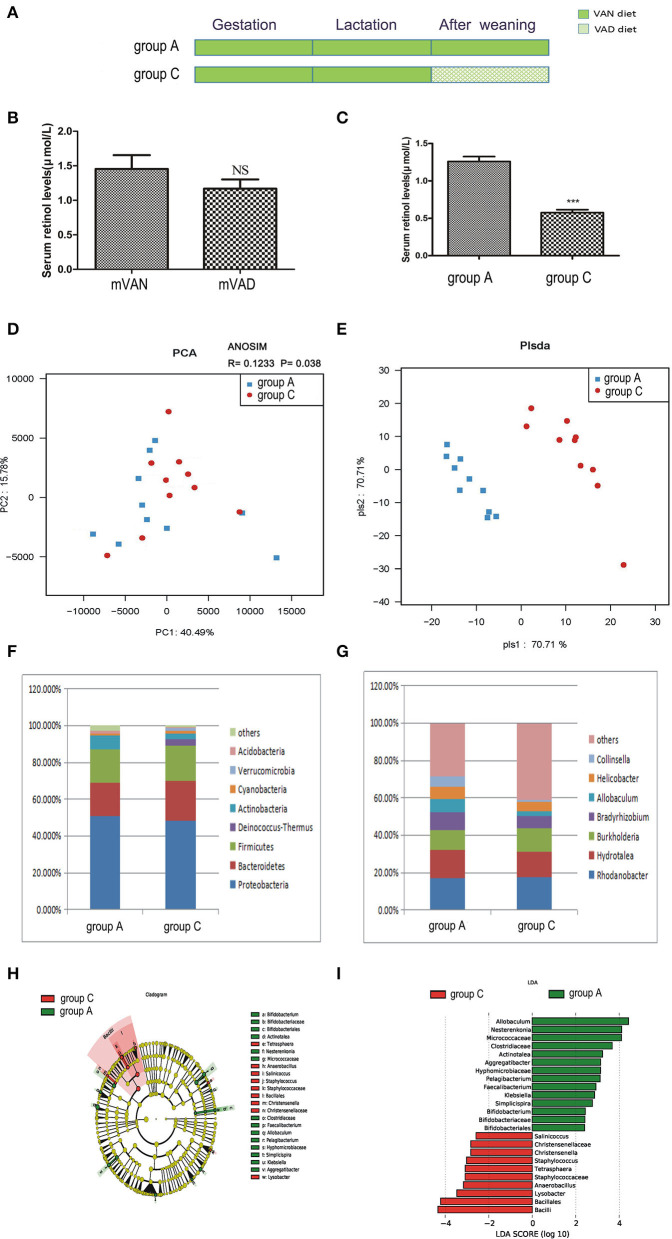
The comparison of colonic mucosal microbiota between the group A and group C. (A) Schematic diagram showing the two offspring groups: group A, group C. The group A pups were delivered and nursed by maternal VAN rats and then fed a VAN diet for 3 wk after weaning. The group C pups were birthed and nursed by maternal VAN rats and fed a VAD diet for 3 wk after weaning. (B) The serum retinal levels of maternal rats. Serum VA levels were detected by HPLC. Values represent mean ± SD. n = 10 mVAN and 10 mVAD, p = NS (not significant) by Student's t-test. (C) The serum retinal levels of offspring at 6 weeks old. Serum VA levels were detected by HPLC. Values represent mean ± SD. n = 10 group A and 10 group C, ***P < 0.001 by Student's t-test. (D,E) The PCA and PLS-DA analysis of the samples between the group A and group C. (D) PCA scores were plotted based on the relative abundance of OTUs (n = 10). (E) PLS-DA was plotted based on the unweighted UniFrac distance metrics (n = 10). The red circles represent for the group C, blue squares for the group A. (F) The phylum level of dominant bacteria with relative abundance more than 1% in the two groups. (G) The genus level of dominant bacteria with relative abundance more than 5% in the two groups. (H,I) Different structures of colonic mucosal microbiota in rats with VAN or VAD diet by LEfSe analysis. (H) A cladogram of the statistical and biological differences in the colonic microbiota between the group A and group C, which are shown by the color of the most abundant phylotypes (red indicating group C, green group A, and yellow non-significant) (n = 10). (I) A histogram of the LDA scores for the most abundant phylotypes (n = 10).